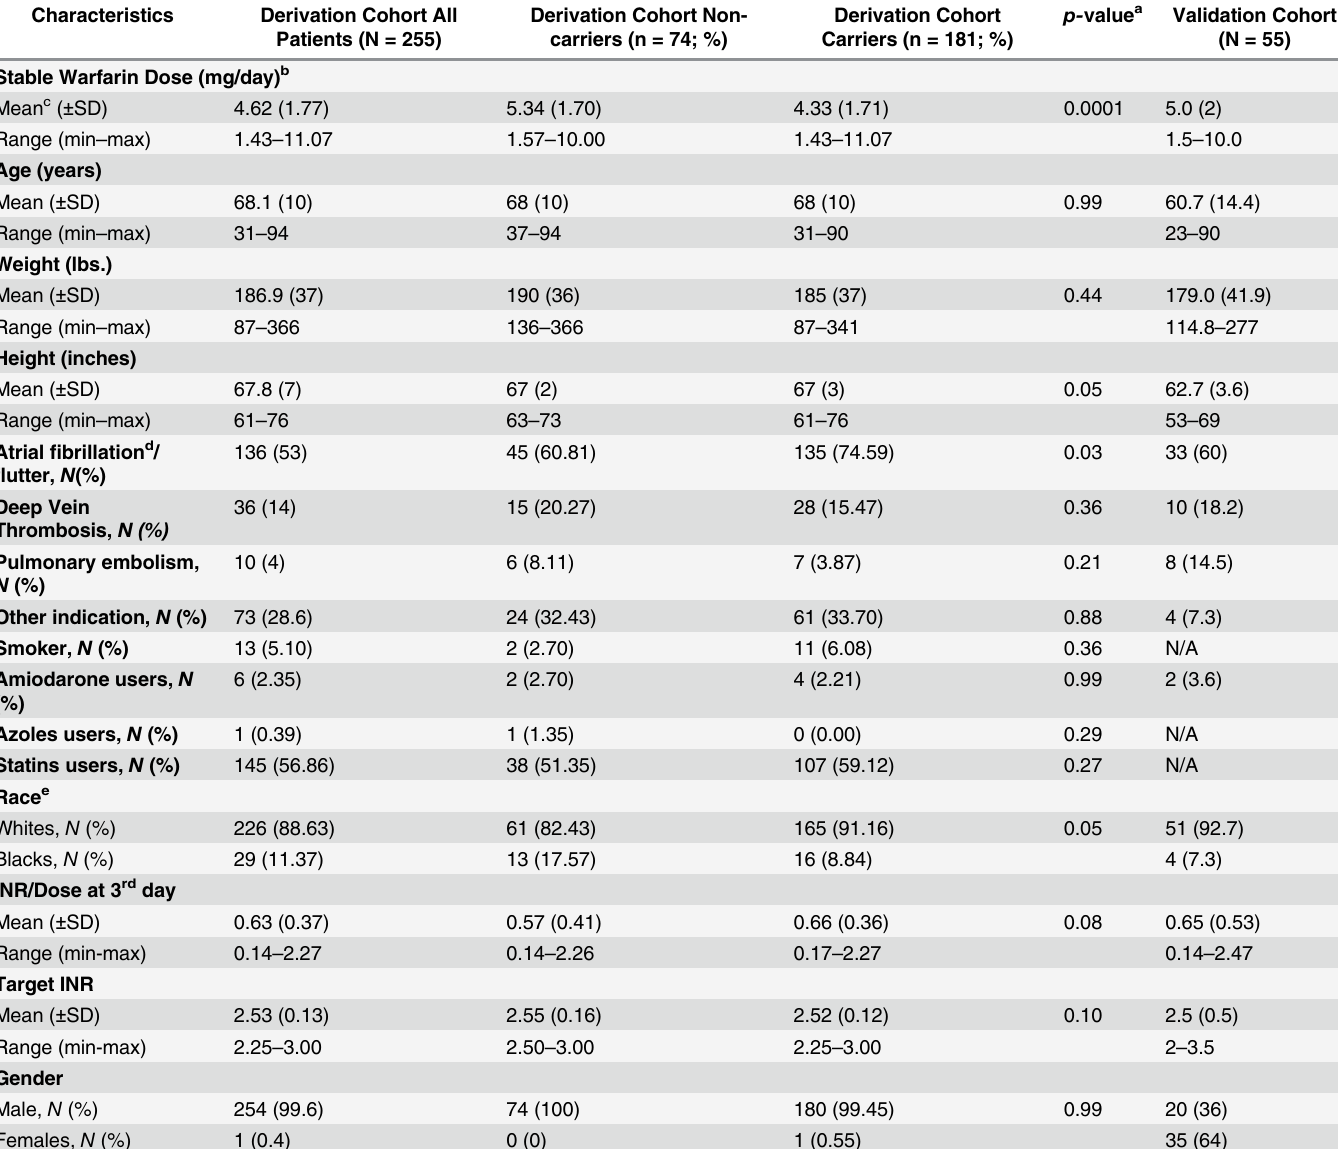
Table 1. Descriptive clinical (non-genetic) and demographic characteristics of the derivation cohort (N = 255 warfarin-treated patients from VACHS) and the independent sample of 55 warfarin-treated Puerto Ricans from the Brownstone Clinic in Hartford, CT (validation